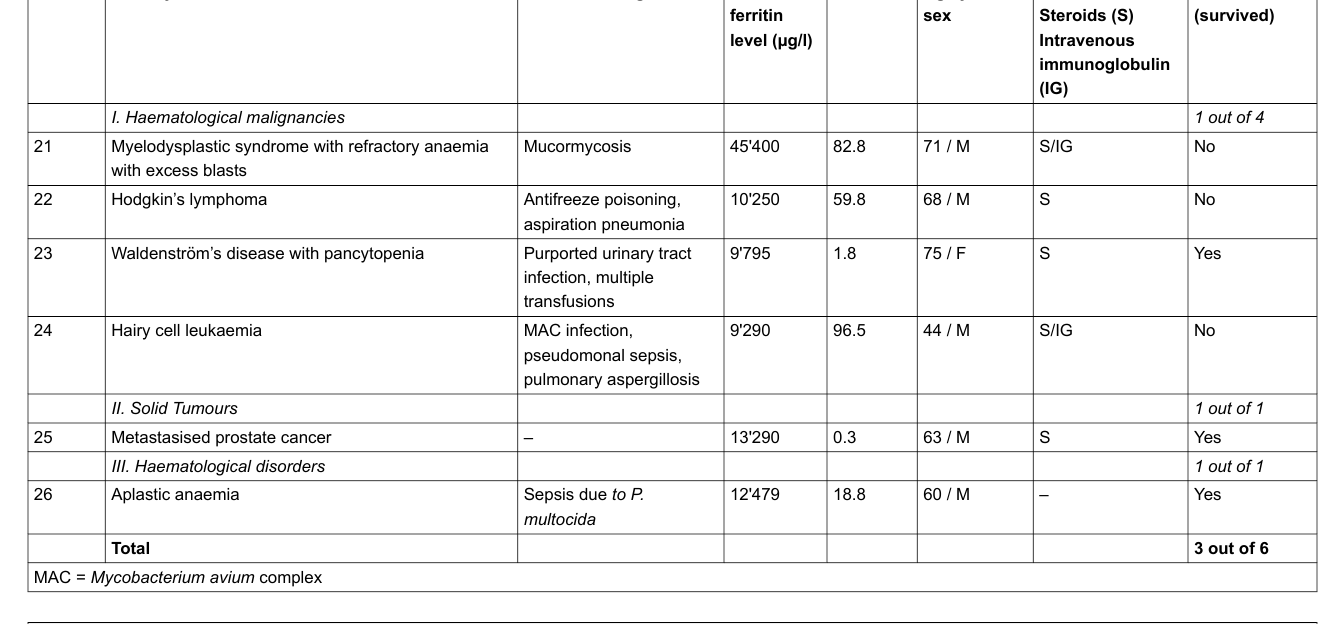
Table 5: Details of patients in group C.